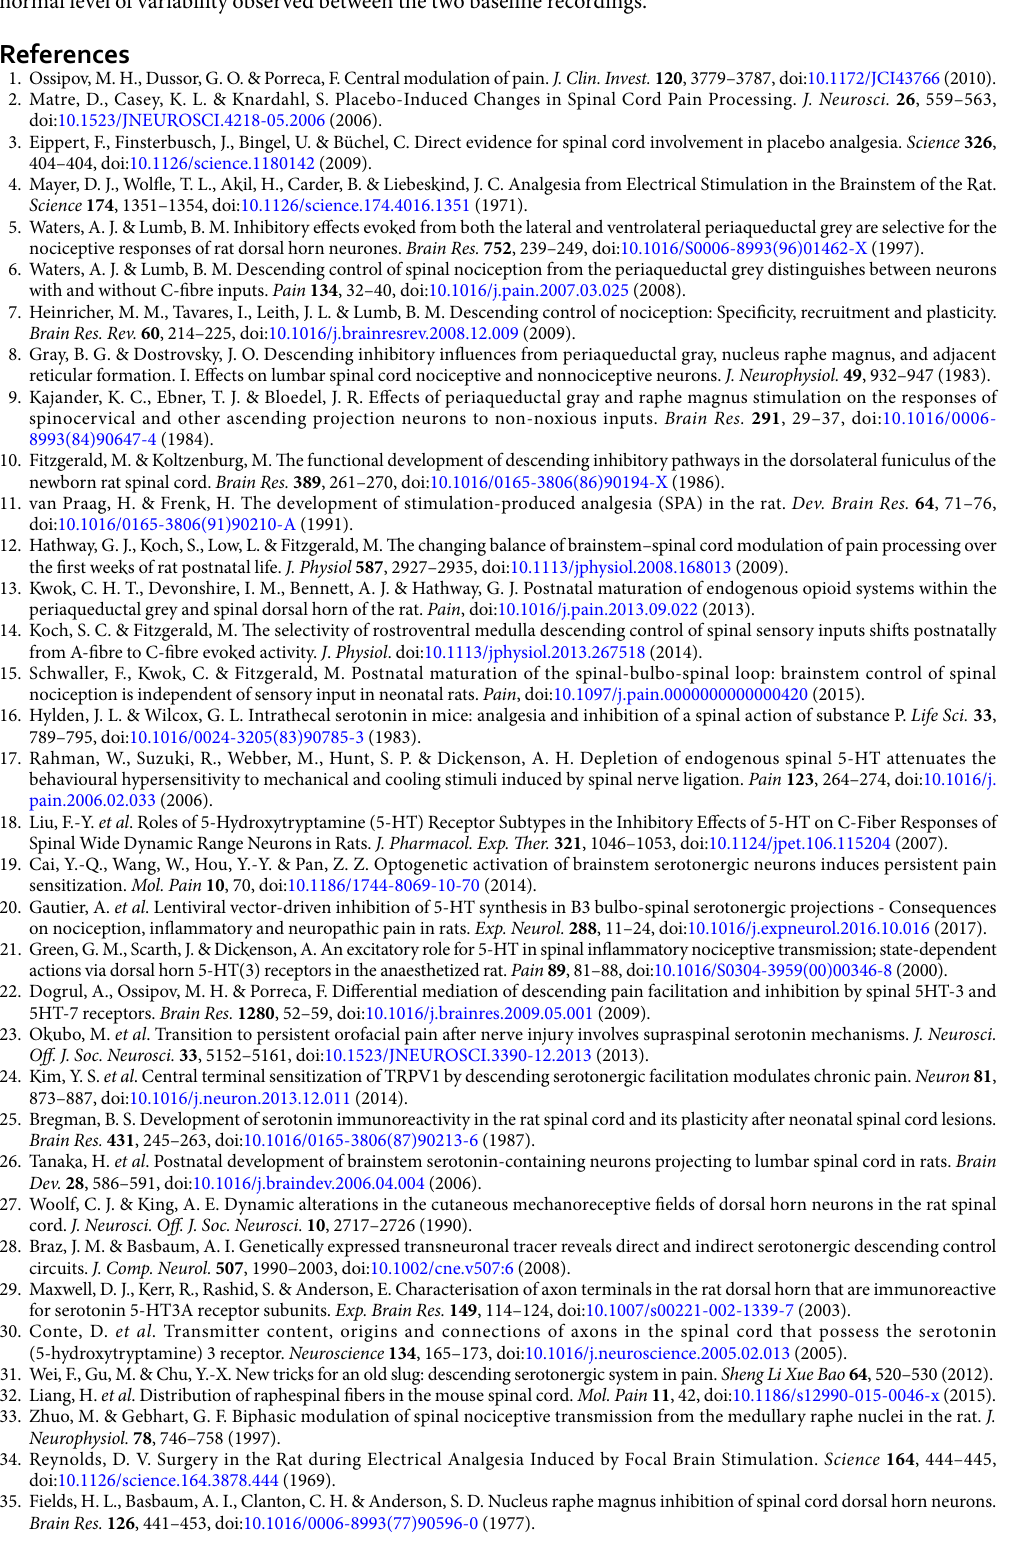
bouts. Repeated measures one-way or two-way ANOVAs with Bonferroni post hoc analysis were performed to analyse within-cell and between population (baseline vs 10 µ A or 100 µ A) changes caused by RVM stimulation. Data sets which were not normally distributed were compared with repeated measures Friedman Tests. Brush and pinch-evoked firing activity data from saline and 5,7-DHT treated animals was also expressed as the percentage change from baseline 1 firing activity. Cells were classified as facilitated or inhibited by RVM stimulation if firing rates increased or decreased by > 20% of baseline values, respectively. This threshold was chosen as it is above the normal level of variability observed between the two baseline